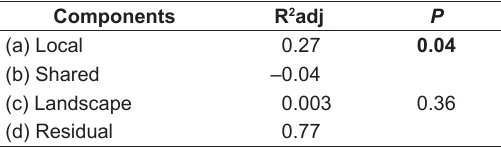
Figure 3. Land use and cover class in the 30 sub-basins upstream of the collection points. Table 3. Individual importance of the local and landscape components in determining chlorophyll- a